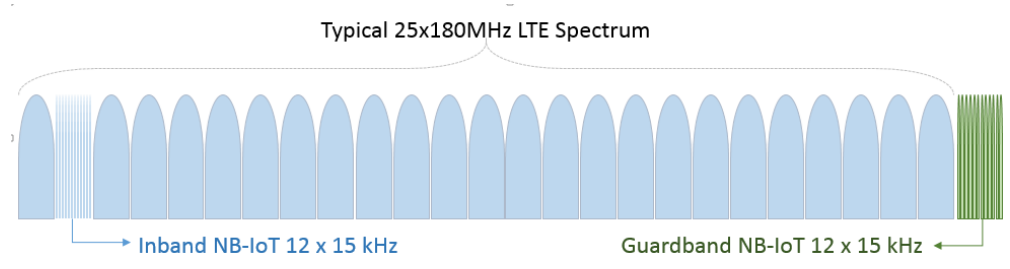
Figure 16. NB-IoT operation